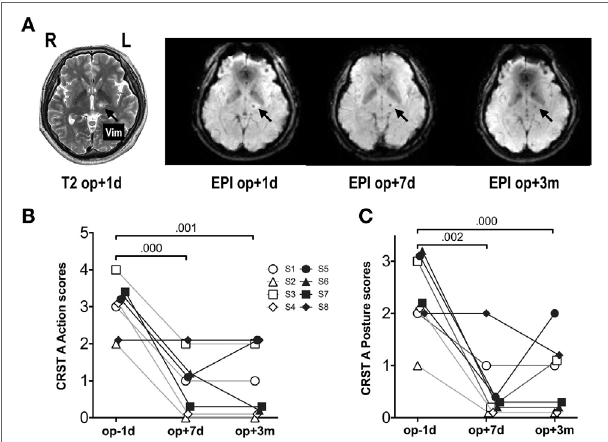
FIgURe 1 | MRI and fMRI scans and symptom severity measures before and after thalamotomy. (A) Lesion locations in T 2 -weighted images and fMRI echo-planar imaging (EPI) after MRgFUS thalamotomy in a patient. The target lesion is the left ventralis intermedius nucleus (Vim) of the thalamus (arrow). (B) Clinical Rating Scale for Tremor Part A (CRST A) action scores. (C) CRST A posture scores. Repeated-measures ANOVA for both scores showed significant session effects ( p < 0.001). The numbers over the lines indicate p -values following post hoc analysis. op − 1d, op + 1d, op + 7d, and op + 3m indicate 1 day before treatment, 1 day, 7 days, and 3 months after treatment. S1–S8 refers to subjects 1–8.